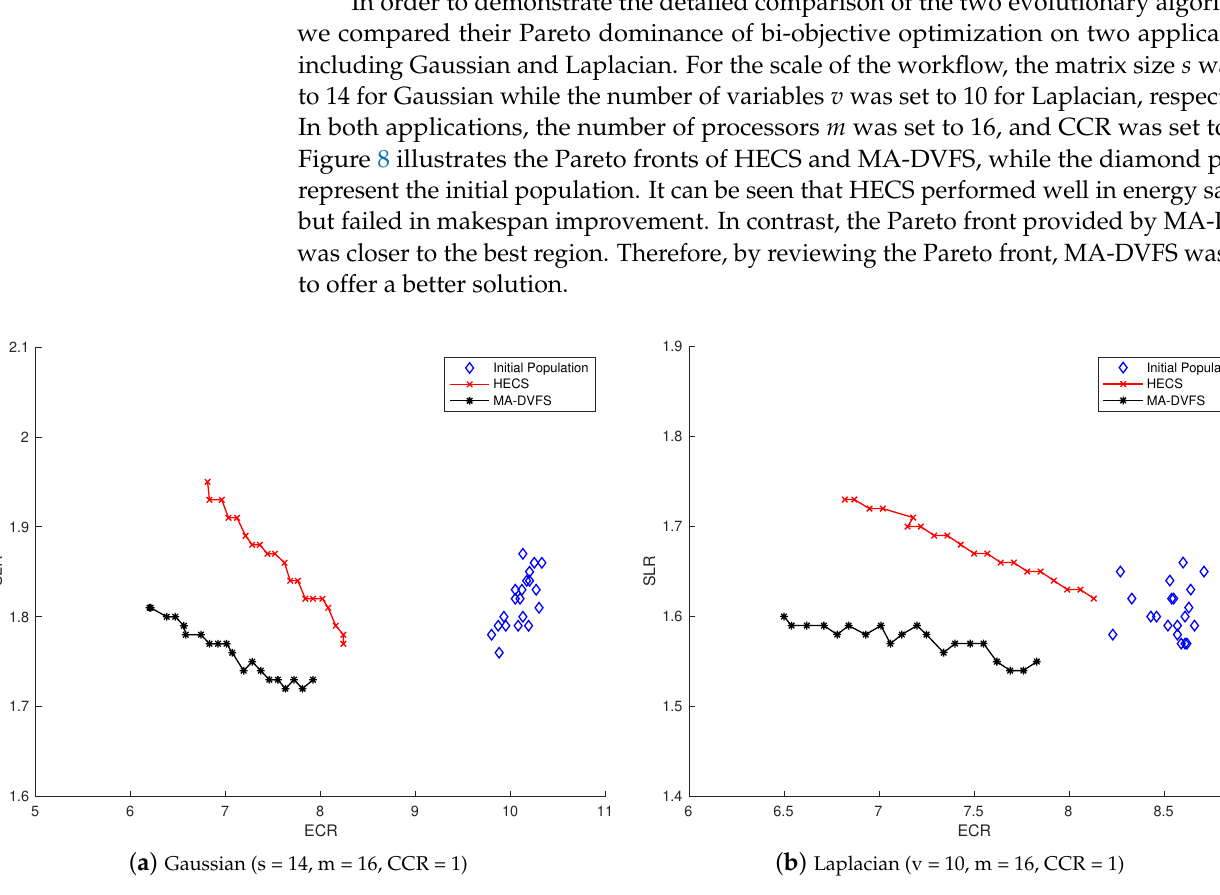
Figure 8. Pareto fronts of two evolutionary algorithms. SLR, schedule length ratio; ECR, energy consumption